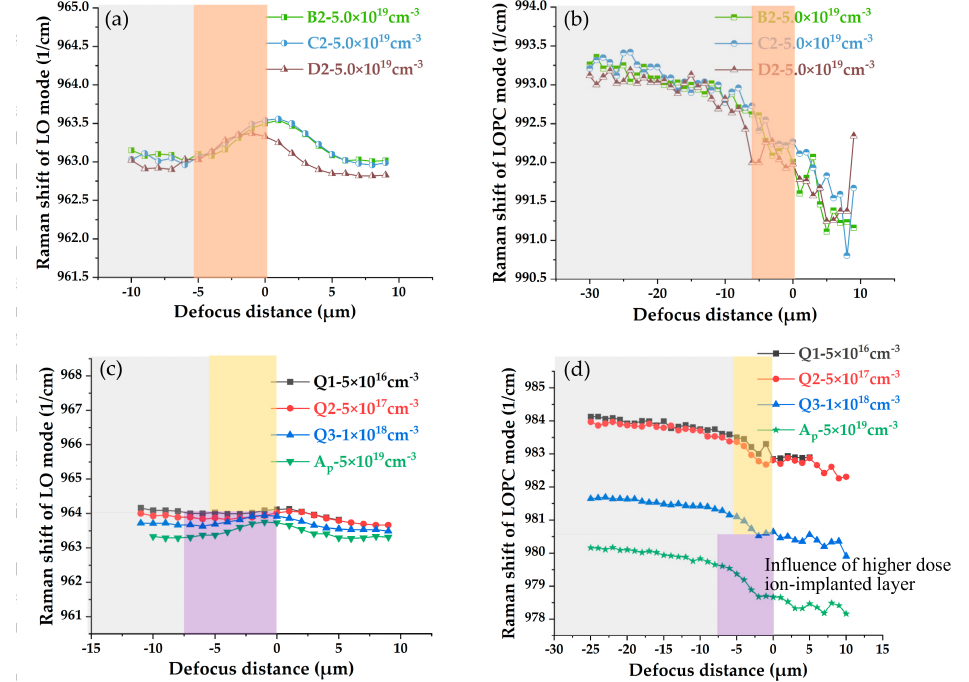
Figure 8. The variation of the LO and LOPC peak position with the defocus distance, in which gray blocks represent the substrates and the di ff erent colored blocks represent the epitaxial layers of di ff erent samples (according to Table 1): ( a ) LO mode distribution along z-axis of B2, C2, and D2; ( b ) LOPC mode distribution along the z-axis of B2, C2, and D2. ( c ) LO mode distribution along the z-axis of A p , Q1, Q2, and Q3; ( d ) LOPC mode distribution along the z-axis of A p , Q1, Q2, and Q3. The step of